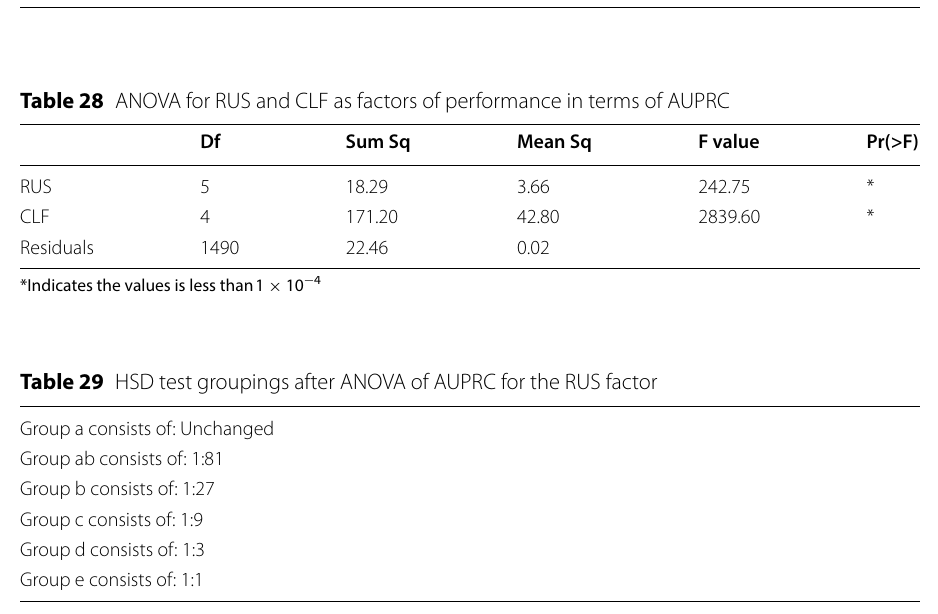
Table 28 ANOVA for RUS and CLF as factors of performance in terms of AUPRC Df